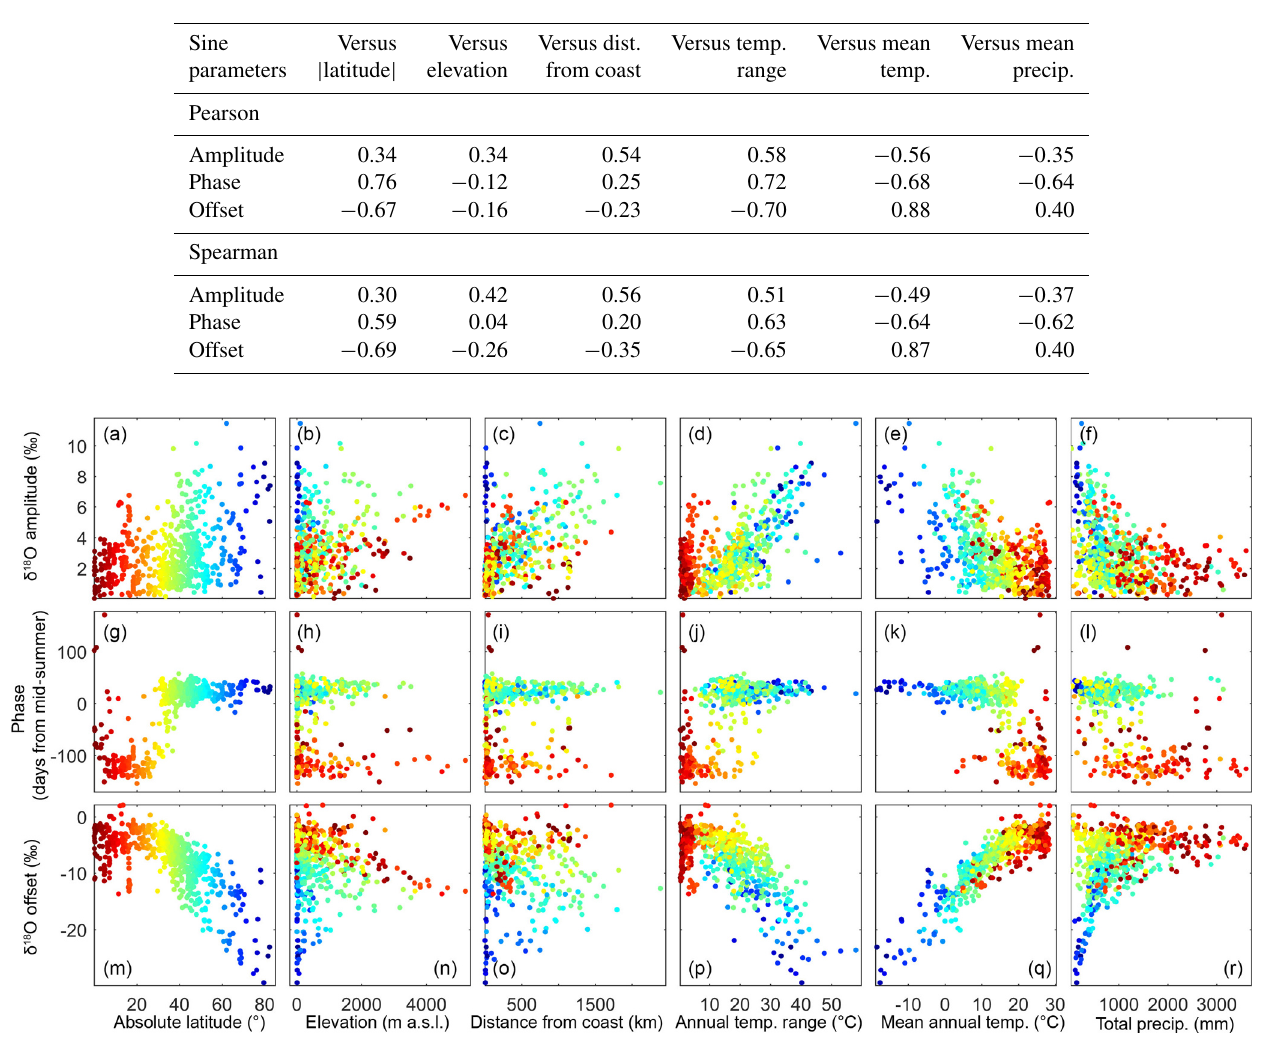
Figure 3. Scatter plots of fitted sine parameters describing precipitation δ 18 O seasonal cycles – (a–f) amplitude, (g–l) phase, (m–r) offset – versus site characteristics. For associated Spearman and Pearson correlation coefficients, see Table 1. Colors indicate absolute latitude (high latitudes in blue, low latitudes in red) as shown in (a) , (g) , and (m)